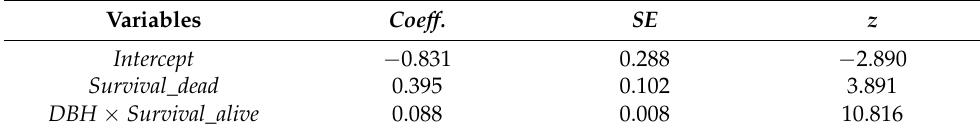
Table 2. The best model for the number of adult exit holes ( N holes ) corresponding to DBH and survival ( dead or alive ). N = 1246 for living trees and n = 338 for dead trees. Coeff. ; estimated coefficient, SE ; standard